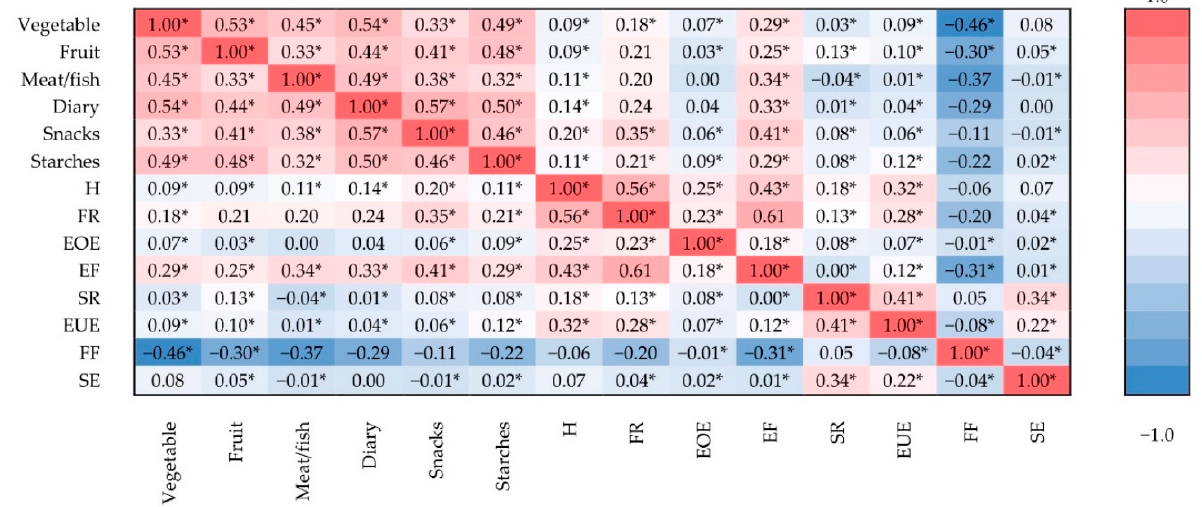
Figure 2. Heatmap of correlation matrix presenting association between food preferences assessed by Food Preference Questionnaire (FPQ) and appetitive traits assessed by Adult Eating Behavior Questionnaire (AEBQ), conducted while using Spearman correlation (due to nonparametric distribution), within the population of the second phase of the Polish Adolescents’ COVID-19 Experience (PLACE-19) Study ( n = 2419); H—Hunger; FR—Food responsiveness; EOE—Emotional over-eating; EF—Enjoyment of food; SR—Satiety responsiveness; EUE—Emotional under-eating; FF—Food fussiness; SE—Slowness in eating; * significant association ( p ≤ 0.05).